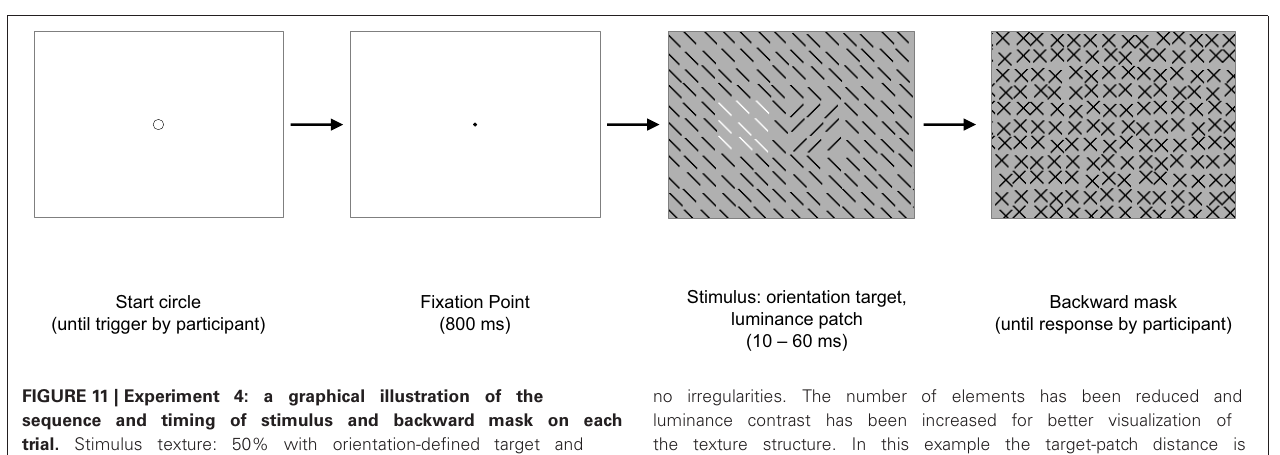
no irregularities. The number of elements has been reduced and luminance contrast has been increased for better visualization of the texture structure. In this example the target-patch distance is